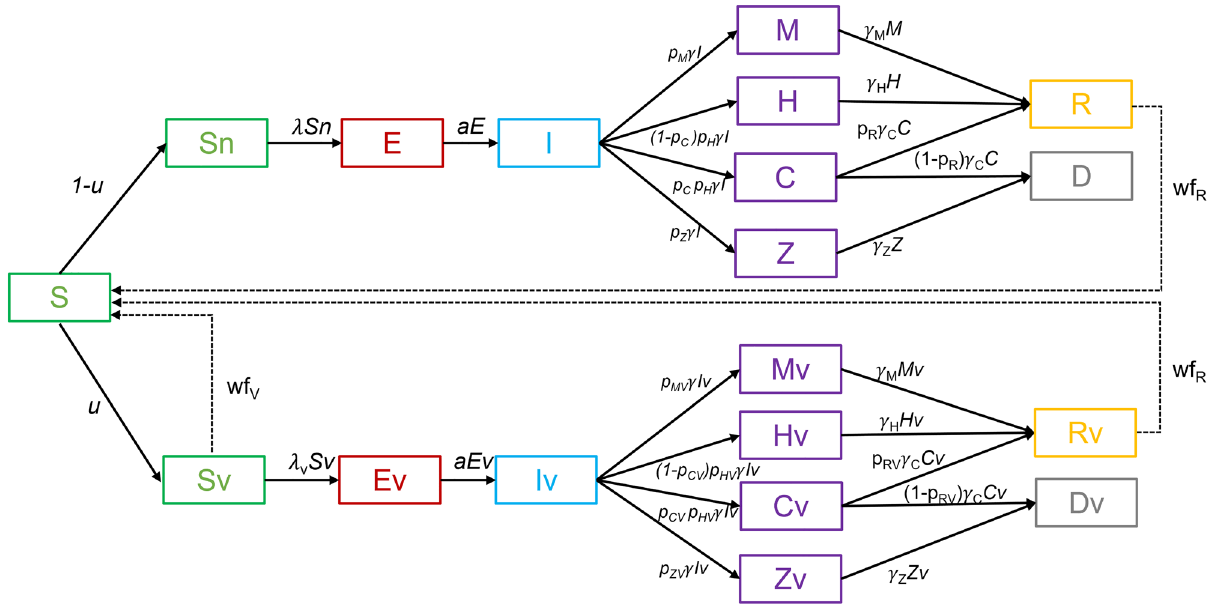
Figure 1. Scheme of the extended SEIR model with additional compartments to model asymptomatic and symptomatic cases with hospital and ICU admissions, split into two separate submodels to model vaccinated and unvaccinated